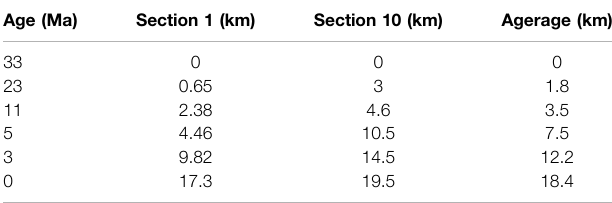
TABLE 2 | Accumulative shortening in the study